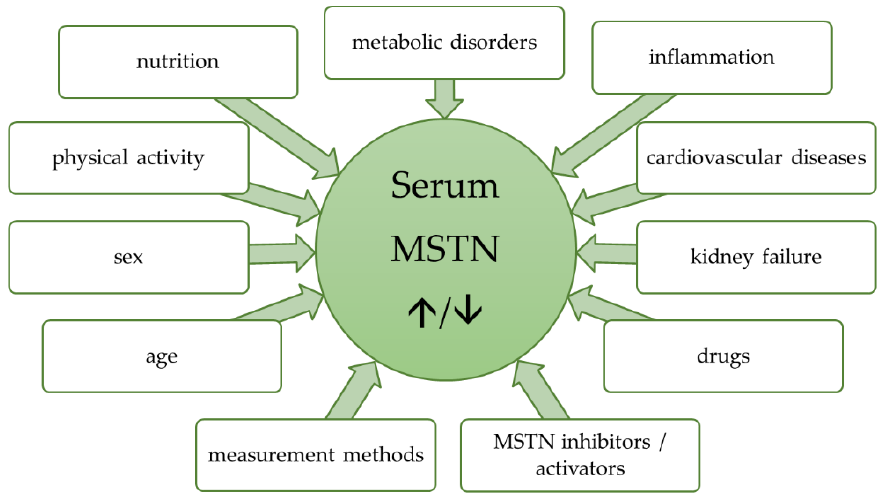
Figure 1. Various factors affecting serum myostatin level.